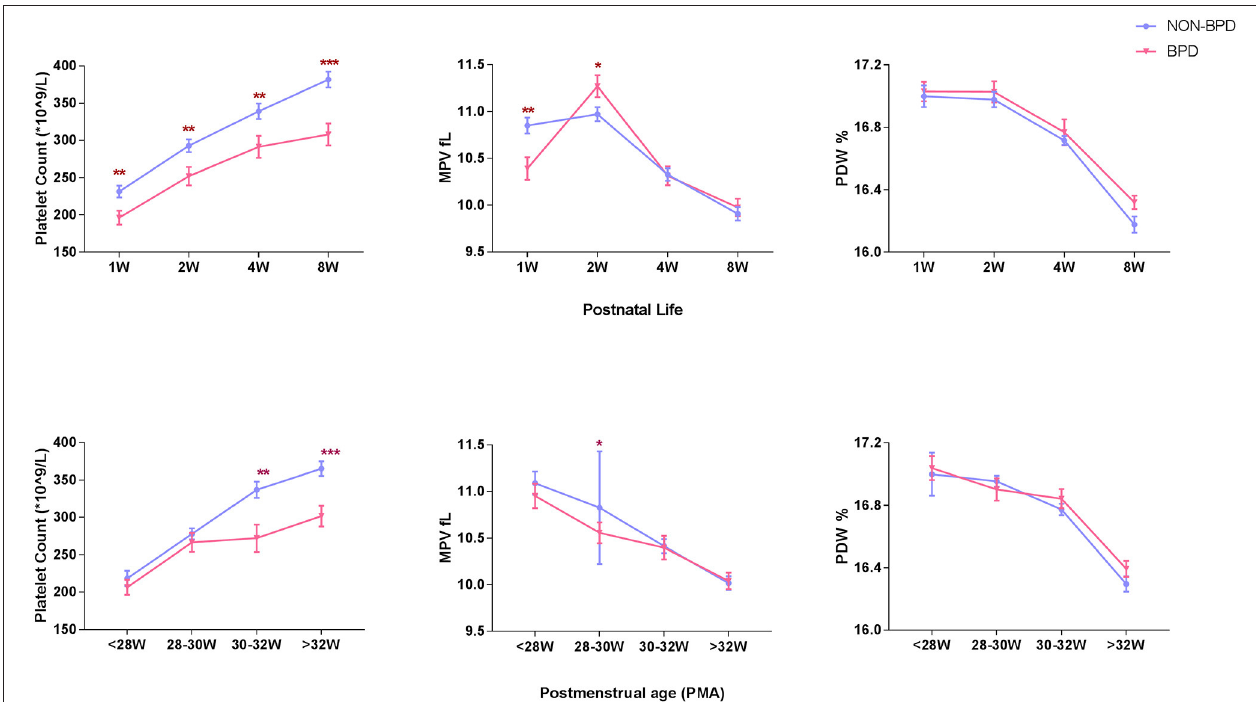
FIGURE 2 | Longitudinal change of platelet parameters defined by postnatal age and postmenstrual age in BPD infants ( N = 83) and non-BPD infants ( N = 171). PLT, platelet count, 10 9 /L, (A) . MPV, mean platelet volume, fL, (B) . PDW, platelet distribution width, %, (C) . Values are expressed as mean ± SD. * p < 0.05, ** p < 0.01, *** p < 0.001, compared with age-matched non-BPDs using the student t